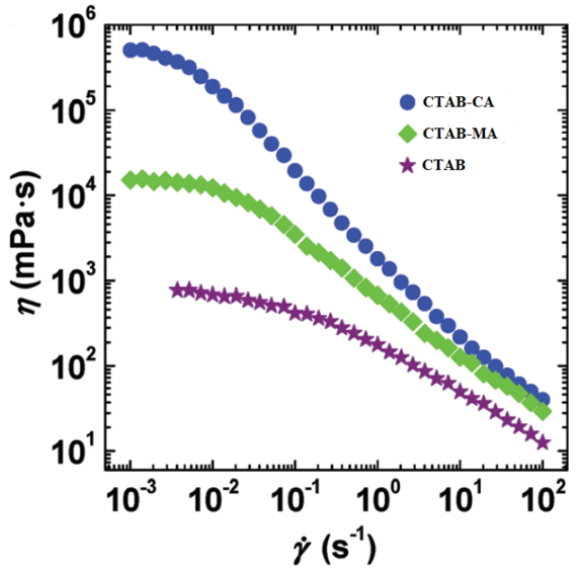
Figure 14. The apparent viscosity for the three types of CTAB based (CTAB, CTAB-MA, and CTAB-CA) VES-fluid at different shear rate, and at 25 ◦